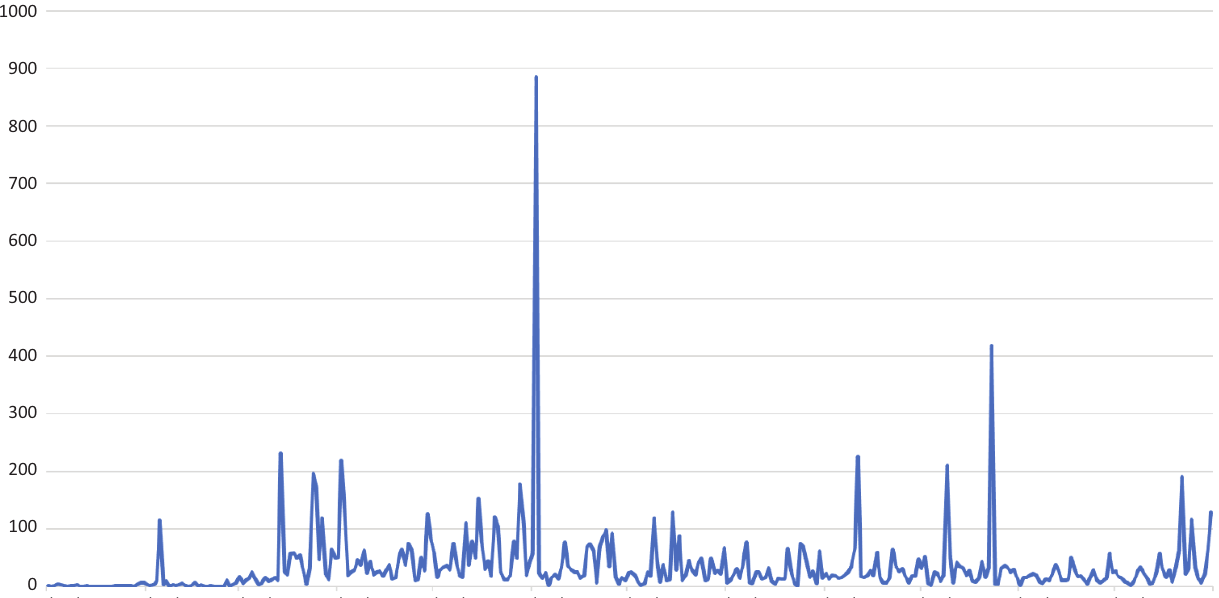
Figure 2. Volume of search results across 2020. another peak, with no correlating development in South Africa’s